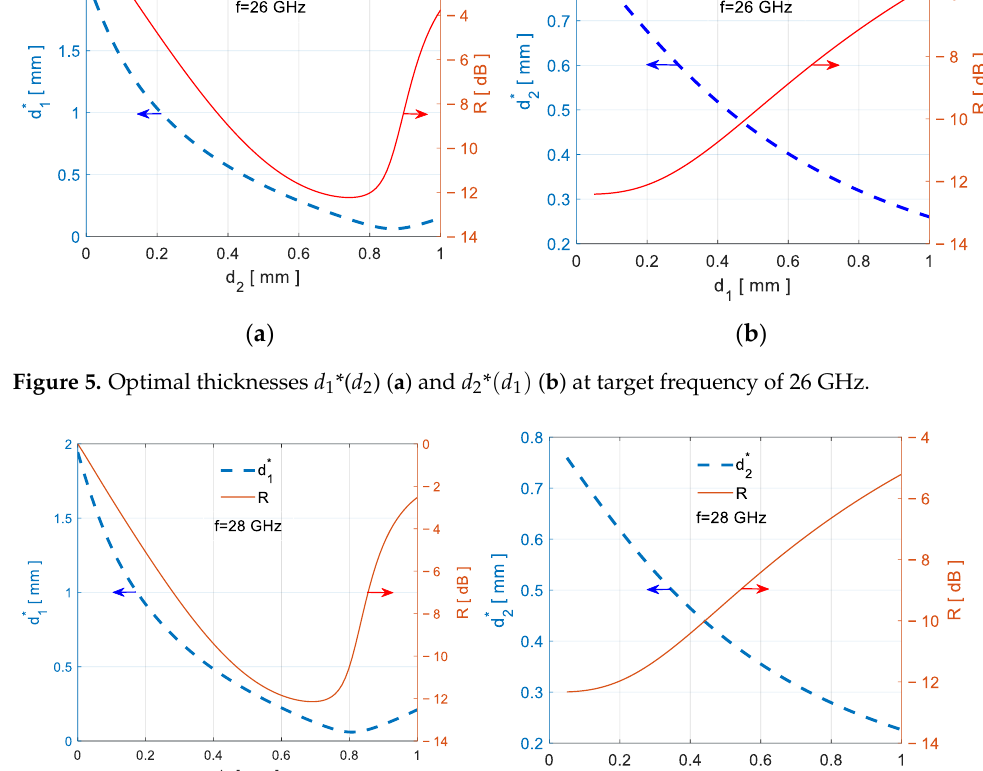
Figure 6. Optimal thickness 𝑑 1∗ ( 𝑑 2 ) ( a ) and 𝑑 2∗ (𝑑 1 ) ( b ) at target frequency 28 GHz.